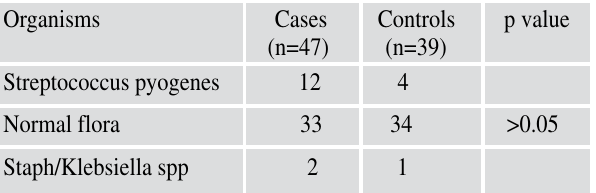
Fig 2. History of sore throat in guttate flare of chronic plaque psoriasis prior to the appearance of skin